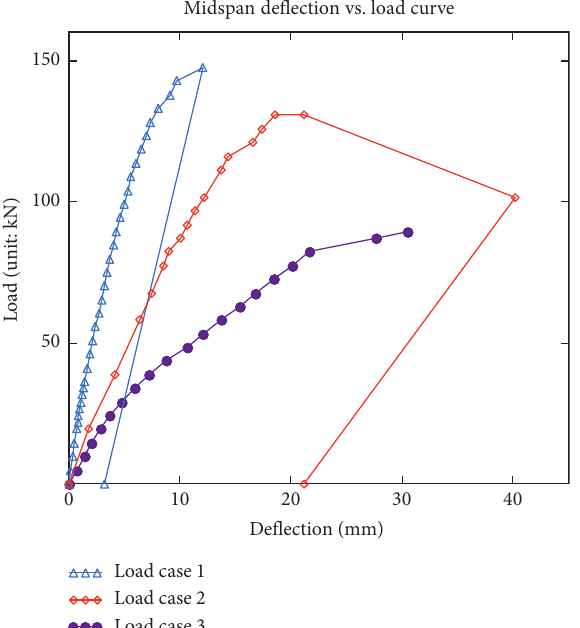
Figure 7: Response of the loaded beam.